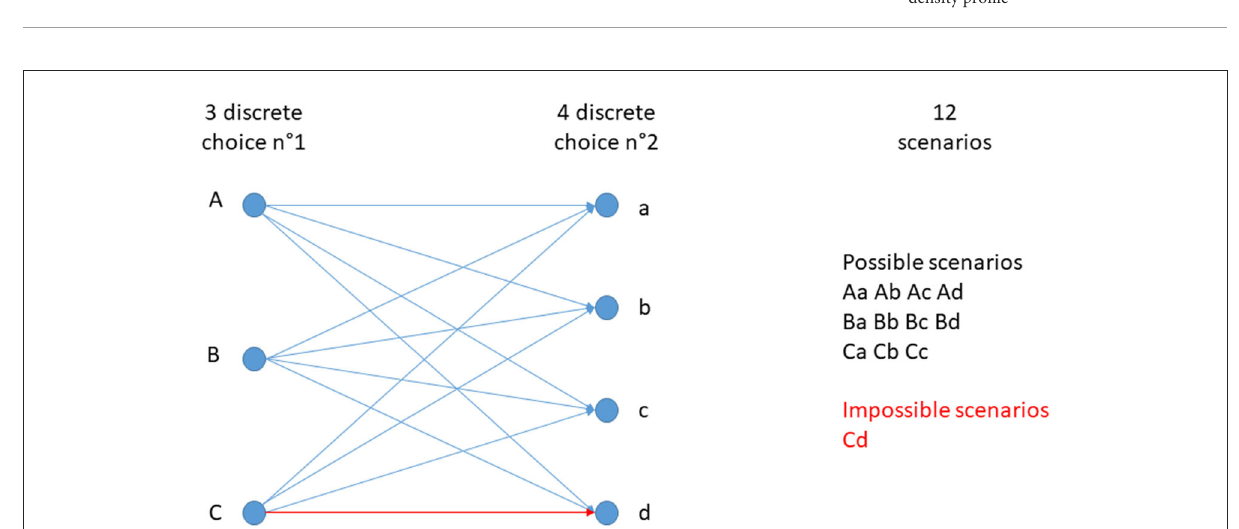
FIGURE4 Systematic generation of scenarios according to choices defined by involved actors.